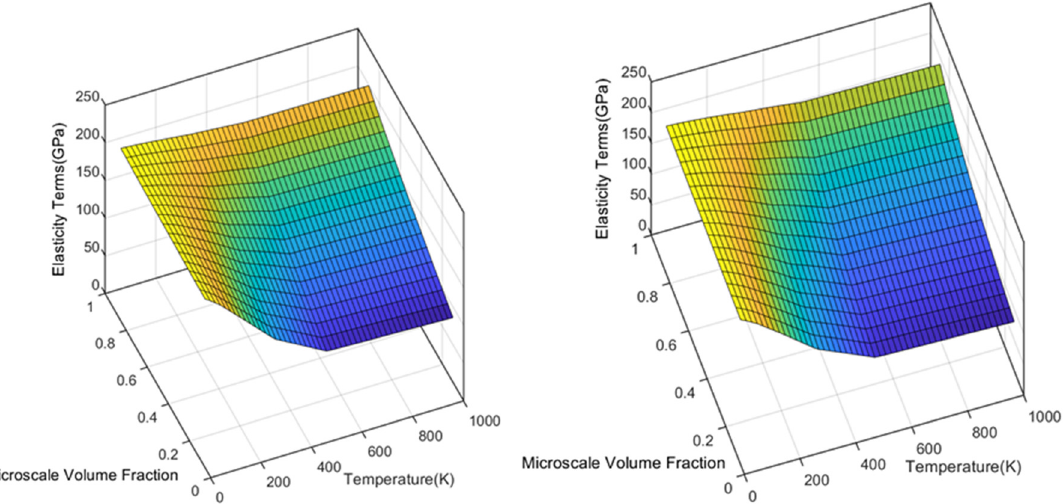
Figure 13: E ff ects of volume fraction of Nb 3 Sn fi lament at microscale and temperature on mesoscale homogenized elasticity terms, ( Left ) D 11⁎ , ( Right ) D D 22⁎ 33⁎ ( )